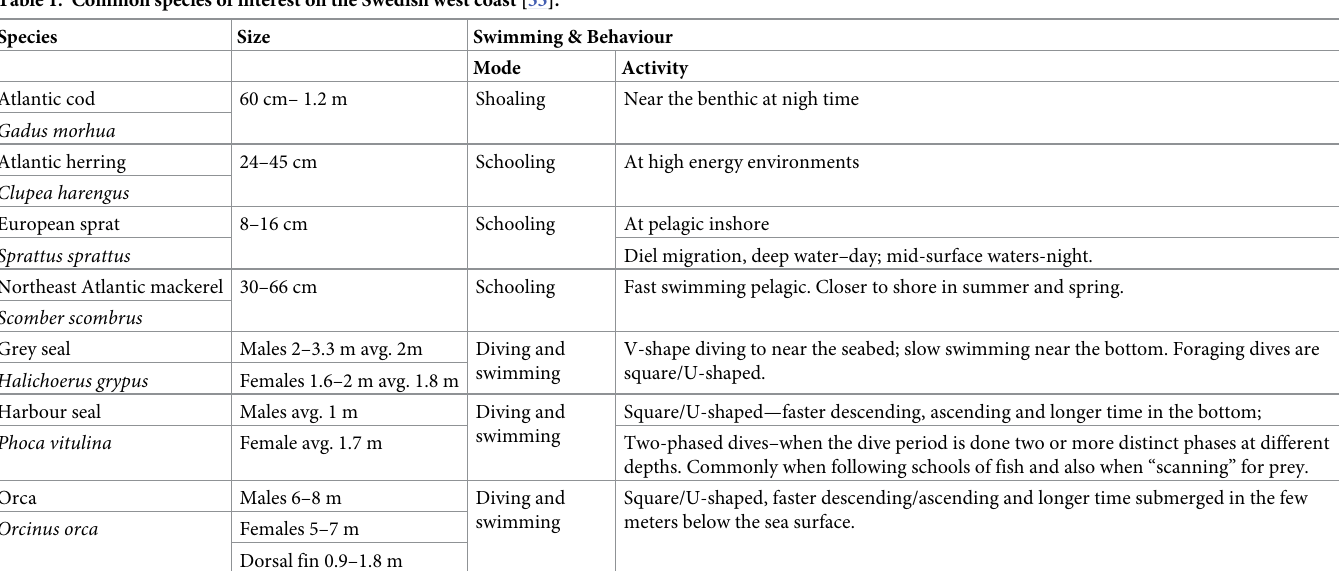
Table 1. Common species of interest on the Swedish west coast [35].